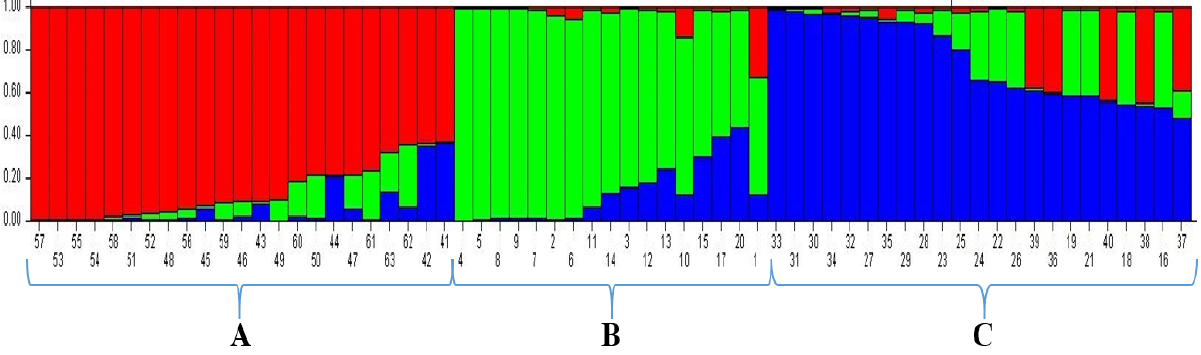
Figure 3. Genetic structure of varieties according to iPBS data (the wheat varieties given in K = 3 (Figure 4) are presented in Table 7).